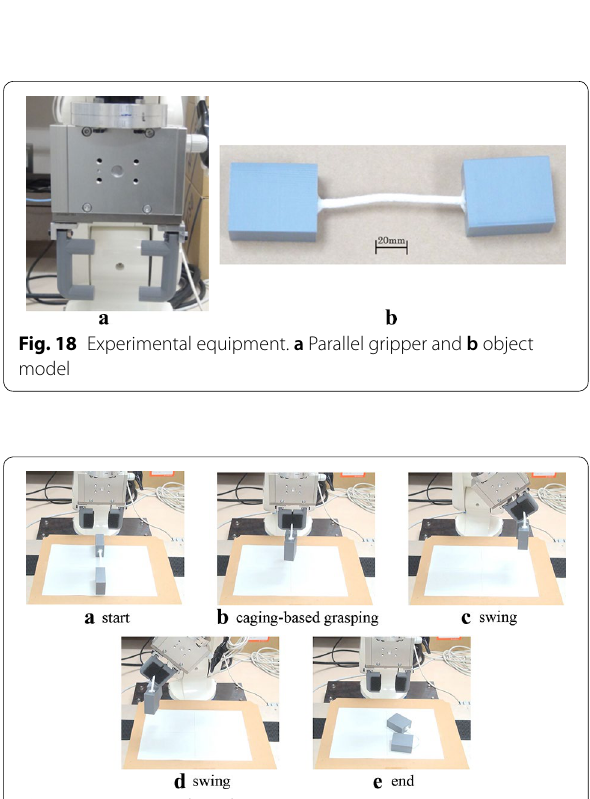
Fig. 19 Experimental